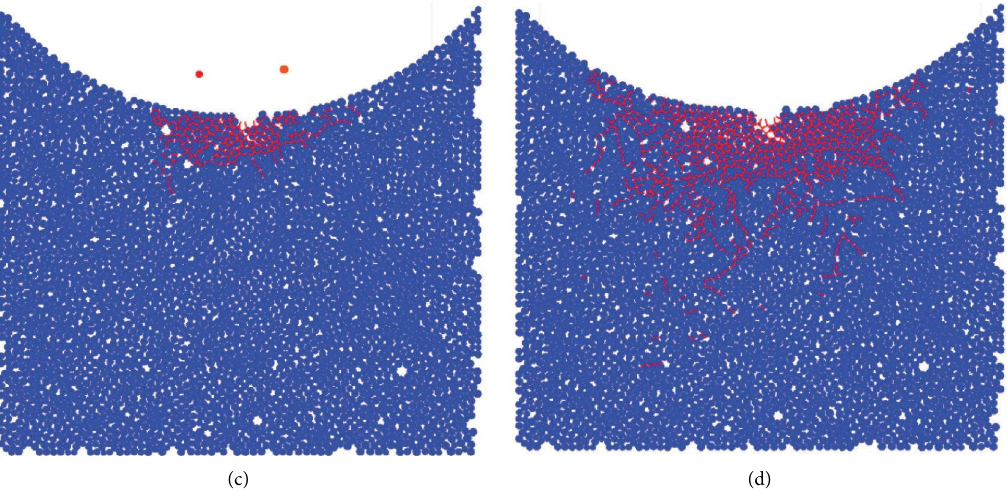
Figure 14: Development law of surrounding rock cracks: (a) one month; (b) six months; (c) two years; (d) four years.